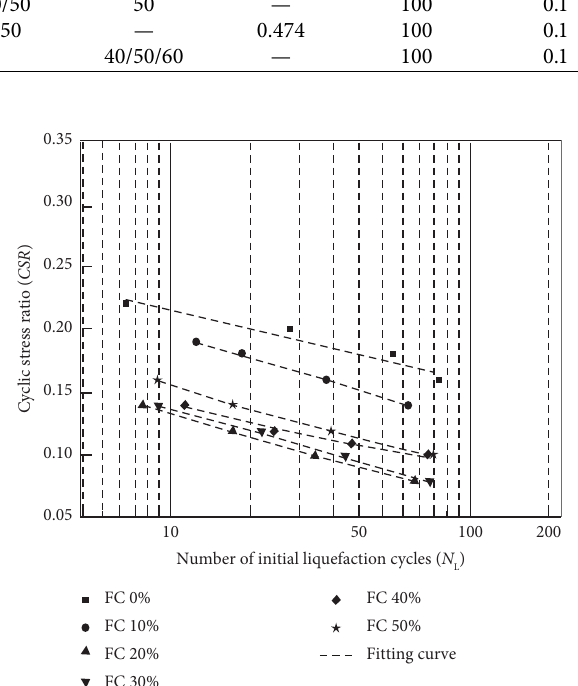
Figure 4: Correlations between the CSR and N a constant D r .